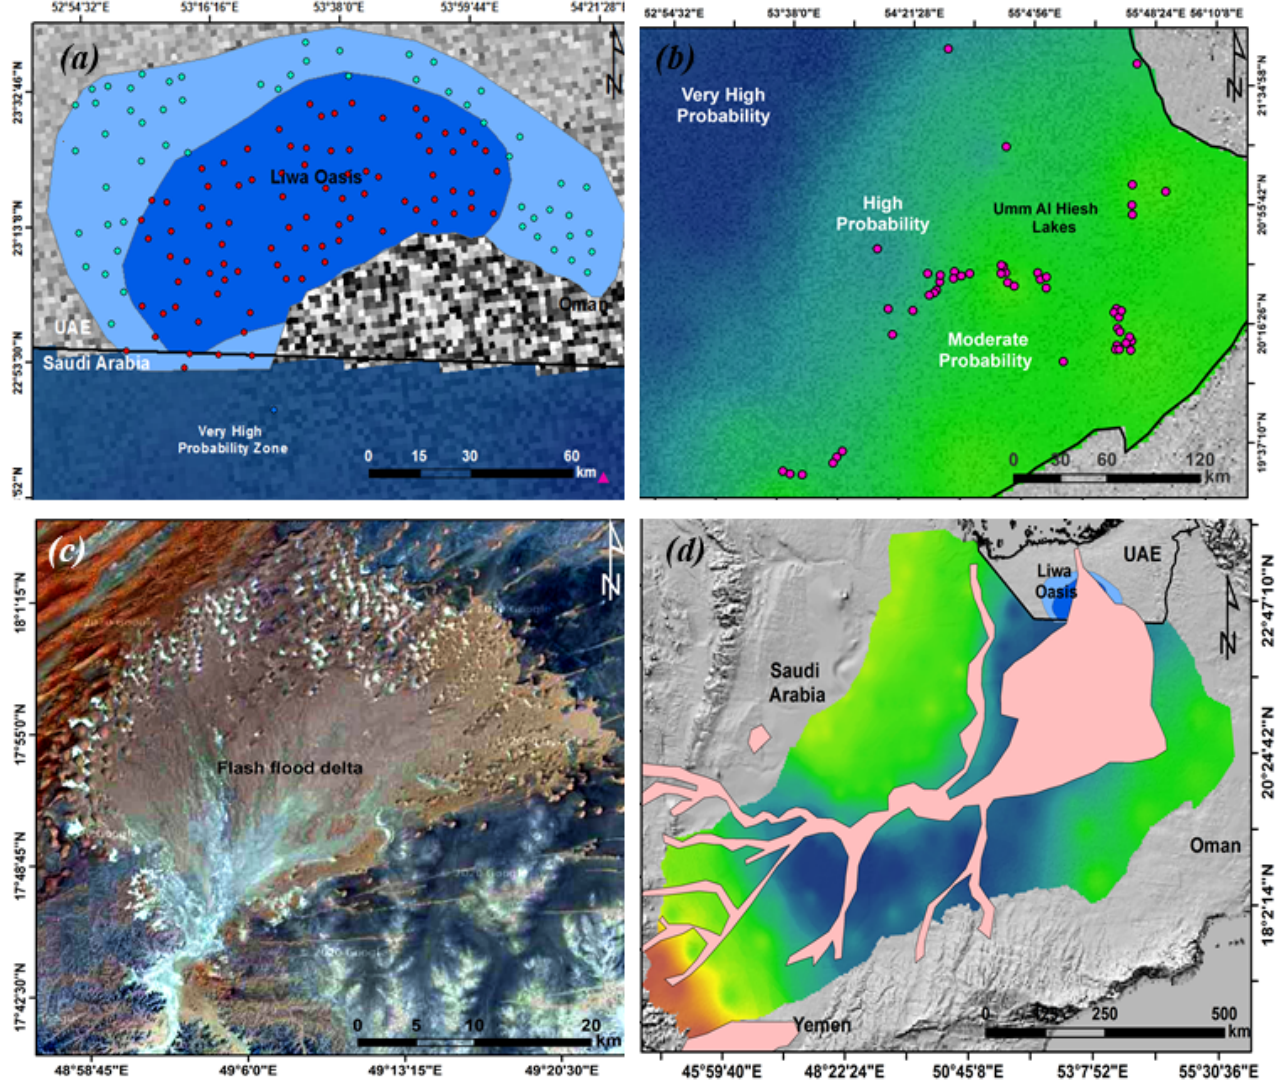
Figure 9. Maps of zones of high and very productivity in Liwa oasis ( a ) mapped using groundwater data by Fragaszy and McDonnell (2016) [73], recovered lakes ( b ) and paleodelta ( c ), and paleochannels and Mutridah depression mapped from SIR-C image using screen digitizing by clarck (1989) [9] ( d ).